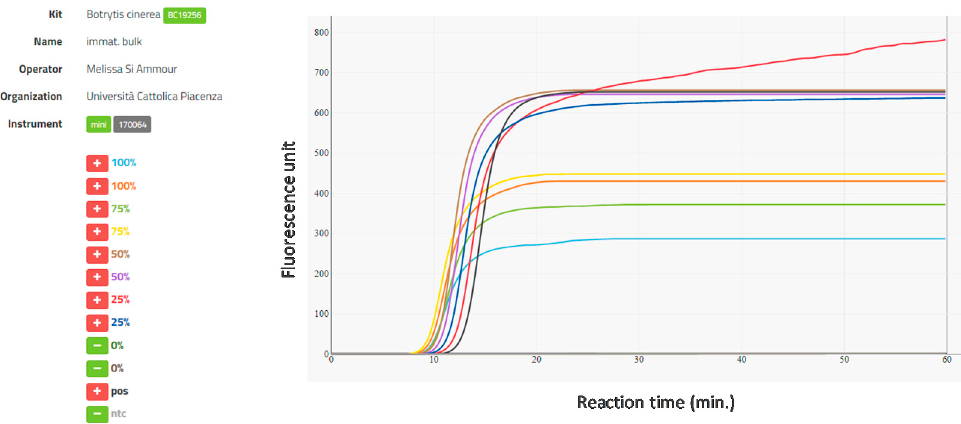
Figure 2. Amplification curves obtained with the real-time LAMP assay for Botrytis cinerea using immature berries in bulk samples with different levels of B. cinerea infection (0, 25, 50, 75, and 100%) and an ICGENE mini (Cat.No.EBT 801) portable instrument. Bulk-berry samples contained 4 berries per sample; for example, the 75% infection level contained 3 berries from bunches that had been inoculated with B. cinerea at flowering and 1 berry from bunches that had not been inoculated with B. cinerea at flowering. Amplification curves and sample labels are colored correspondingly. + indicates amplification, and - no amplification; pos is the positive control consisting of B. cinerea DNA as template, and ntc is the negative control consisting of water as template.